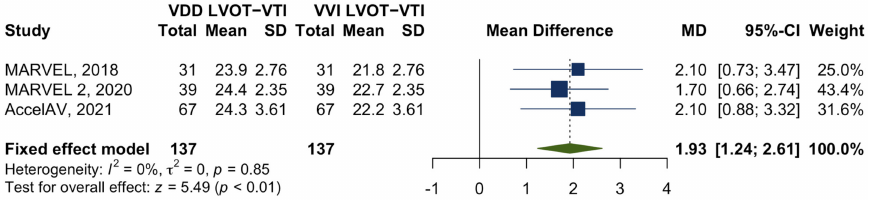
Figure 4. Forest plot of the change in LVOT-VTI comparing the VVI pacing mode with the VDD pacing mode. Abbreviation: LVOT-VTI = Left ventricular outflow tract velocity time integral